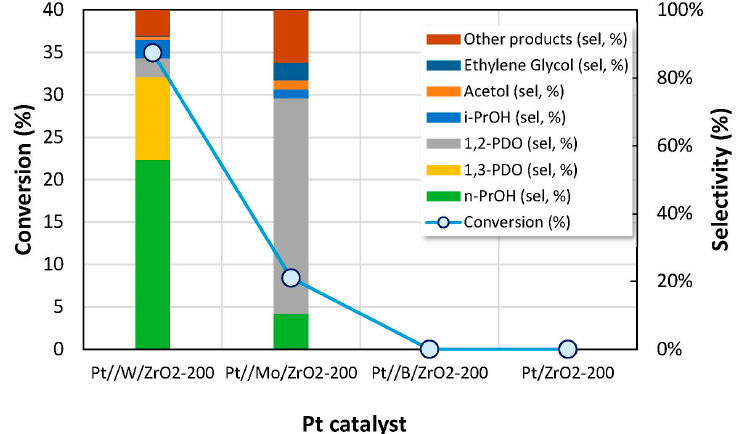
Figure 7. Glycerol conversion and products selectivity obtained for the synthesized catalysts after 12 h of reaction in the liquid-phase glycerol hydrogenolysis at 180 °C. Six bar of H 2 initial pressure, 100 mg of catalyst and 10 mL of glycerol 1.36 M.